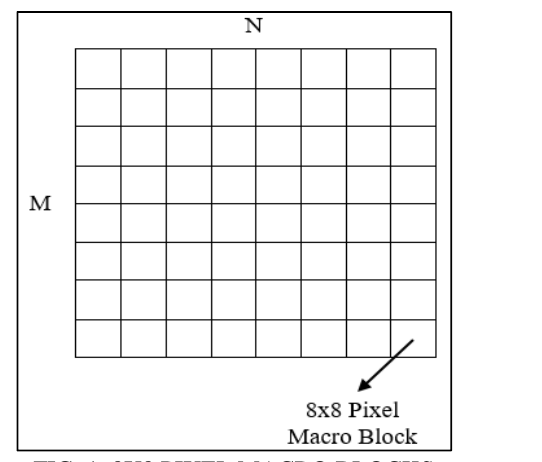
FIG. 1. 8X8 PIXEL MACRO BLOCKS